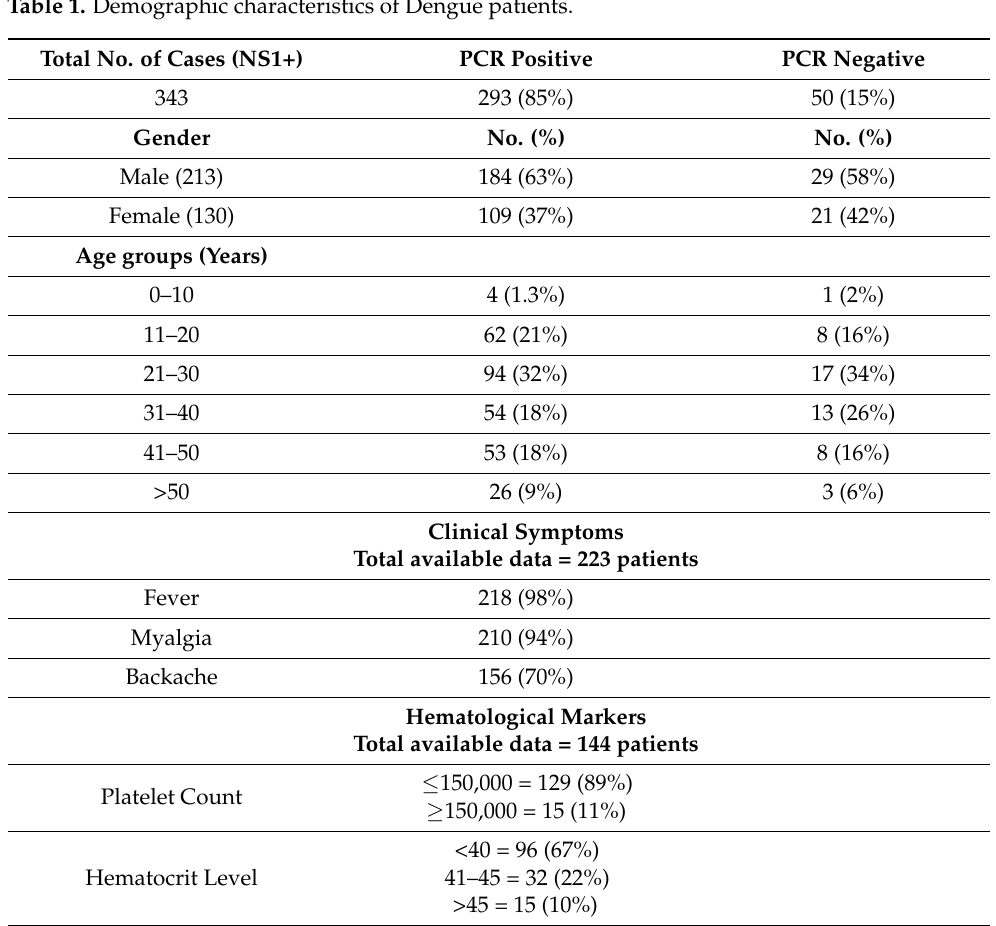
Table 1. Demographic characteristics of Dengue